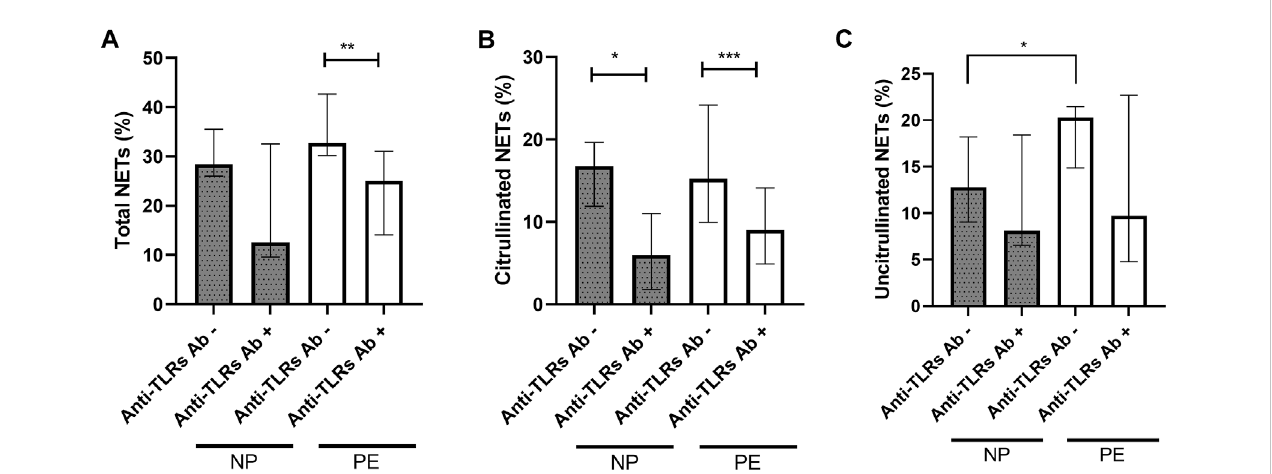
FIGURE 5 Comparisons of the percentages of total NETs (A) and citrullinated NETs (B) formed after stimulation of healthy volunteer neutrophils with plasma from women delivering a normal pregnancy (NP) or preeclampsia (PE) without inhibition and with inhibition by anti-TLR2 and TLR4 blocking antibodies. (A) NP withoutanti-TLR2andTLR4blockingantibodies28.40%[26.06;35.56];NPwithanti-TLR2andTLR4blockingantibodies12.57%[9.59;32.58].PEwithoutanti- TLR2 and TLR4 blocking antibodies 32.79% [30.17; 42.70]; PE with anti-TLR2 and TLR4 blocking antibodies 25.05% [14.10; 31.06]. (B) NP without anti- TLR2 and TLR4 blocking antibodies 16.77% [11.90; 19.65], NP with anti-TLR2 and TLR4 blocking antibodies 5.96% [1.85; 11.03]. PE without anti-TLR2 and TLR4 blocking antibodies 15.23% [9.97; 24.20]; PE with anti-TLR2 and TLR4 blocking antibodies 9.07% [4.92; 14.13]. (C) NP without anti-TLR2 and TLR4 blocking antibodies 12.80% [9.05; 18.23], NP with anti-TLR2 and TLR4 blocking antibodies 8.13% [6.55; 18.43]. PE without anti-TLR2 and TLR4 blocking antibodies 20.26% [14.87; 21.47]; PE with anti-TLR2 and TLR4 blocking antibodies 9.73% [4.79; 22.69]. Anti TLRs+: with inhibition by anti-TLR2 and TLR4 blocking antibodies.Resultsare represented with their medians and interquartileranges [Q1; Q3]. The Bonferroni correction with acut-off at 0.025 was applied to take into account the multiplicity of tests. ** p < 0.01, *** p <